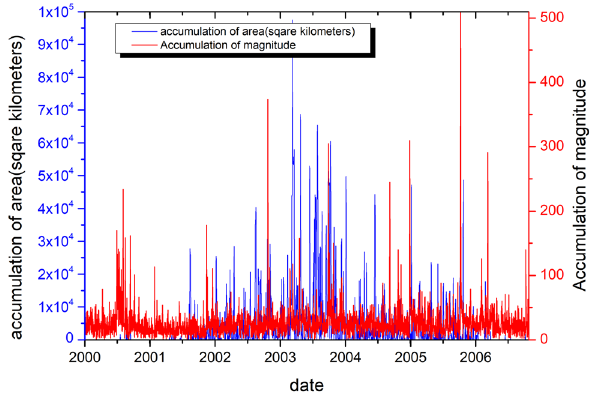
Fig. 11 The counts of series and related events. Left y axis: disaster and earthquake count in series; right y axis: series counts; x axis: distance in space (2-day time threshold)